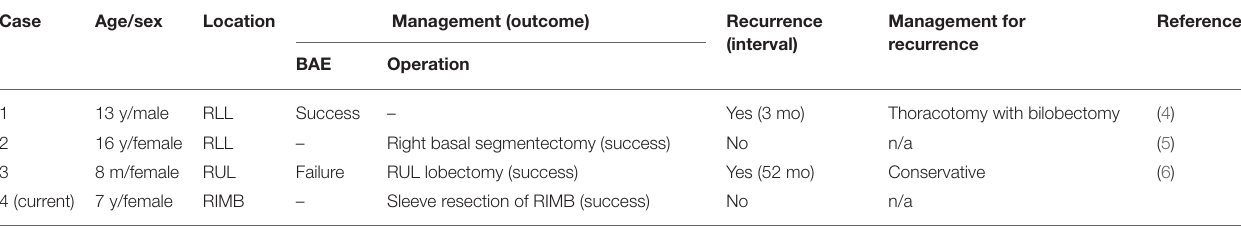
TABLE 1 | Literature review on bronchial Dieulafoy’s disease in children.